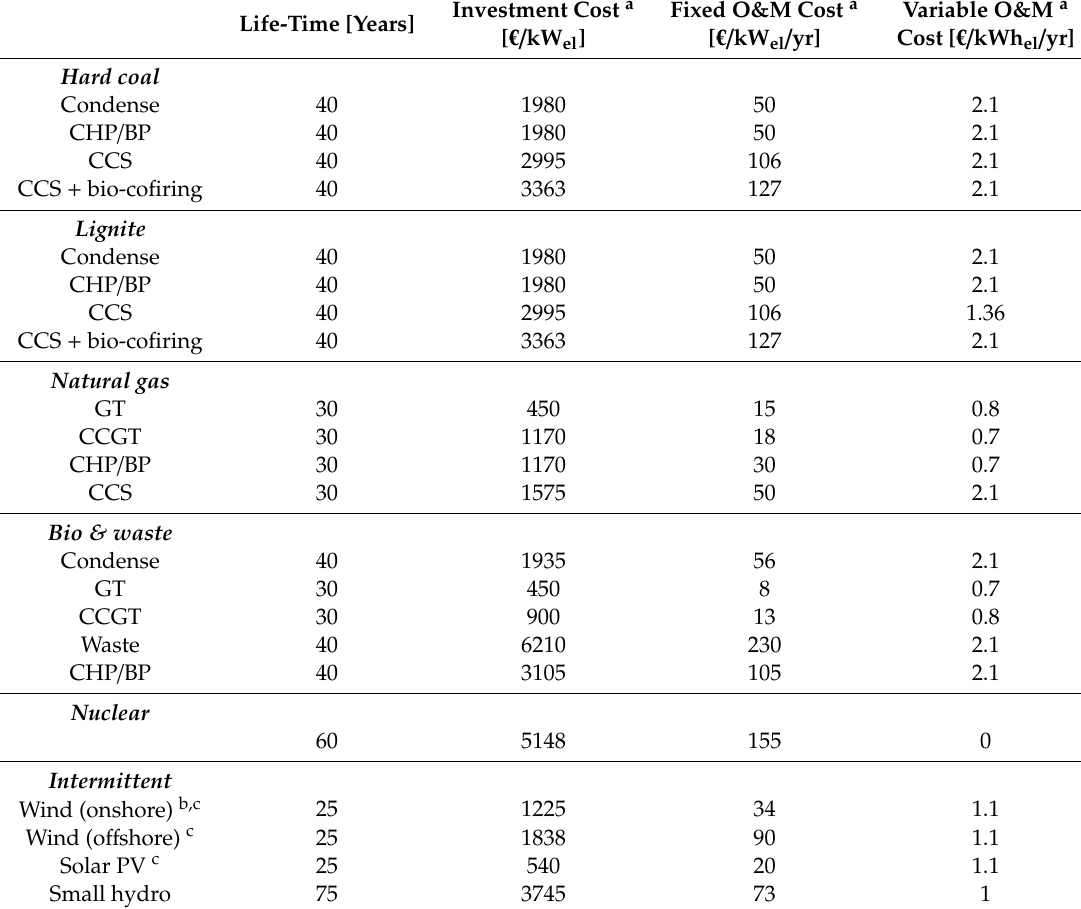
Table A1. Technology investment cost for Year 2050, operational and maintenances costs (O&M) and life-times of some of the key technologies available in the ELIN model [25]. CCS, carbon capture and storage; CHP, combined heat and power; GT, gas turbine; CCGT, combined cycle gas